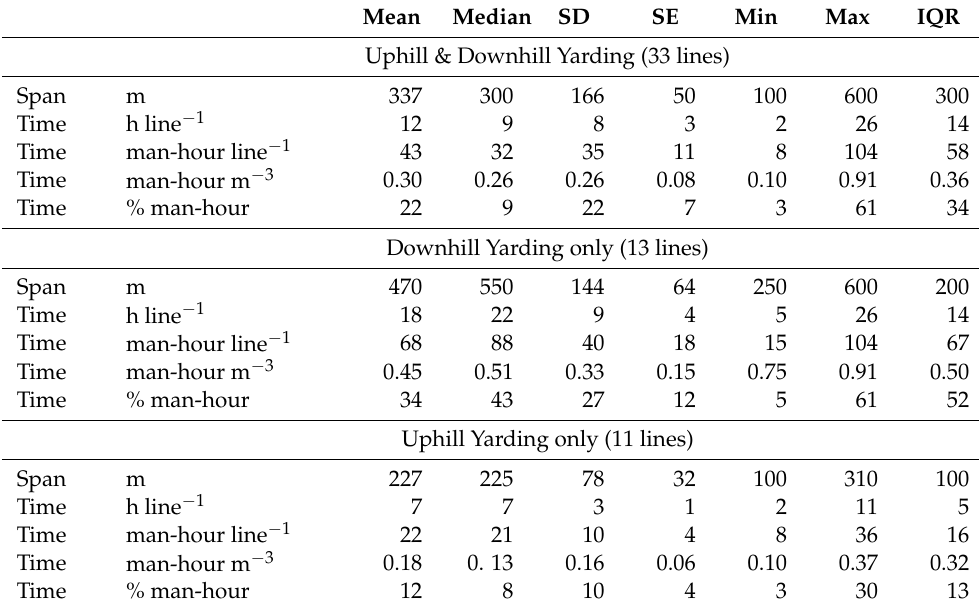
Table 7. Set-up and dismantling: main descriptive statistics ( n = 12).